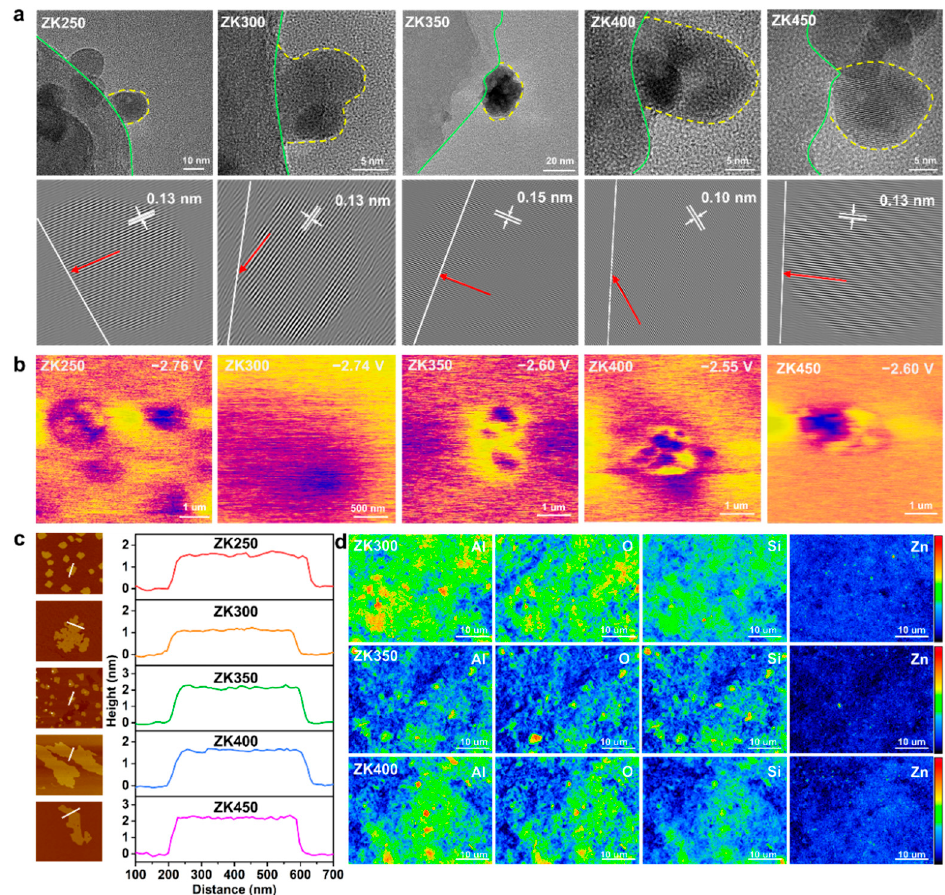
Figure 1. ( a ) HRTEM image; the yellow dot line indicates the border of the nanoparticles, and the green line represents the border of the support. HAADF images of ZnO nanoparticles on the support surface. The white line represents the border of the surface, and the red arrows illustrates the crystal lattice orientation; ( b ) Surface electronic chemical potential distribution; ( c ) The heights of ZnO on the support by AFM; ( d ) Intensity and distribution of Al, Si, O, and Zn of EMPA.